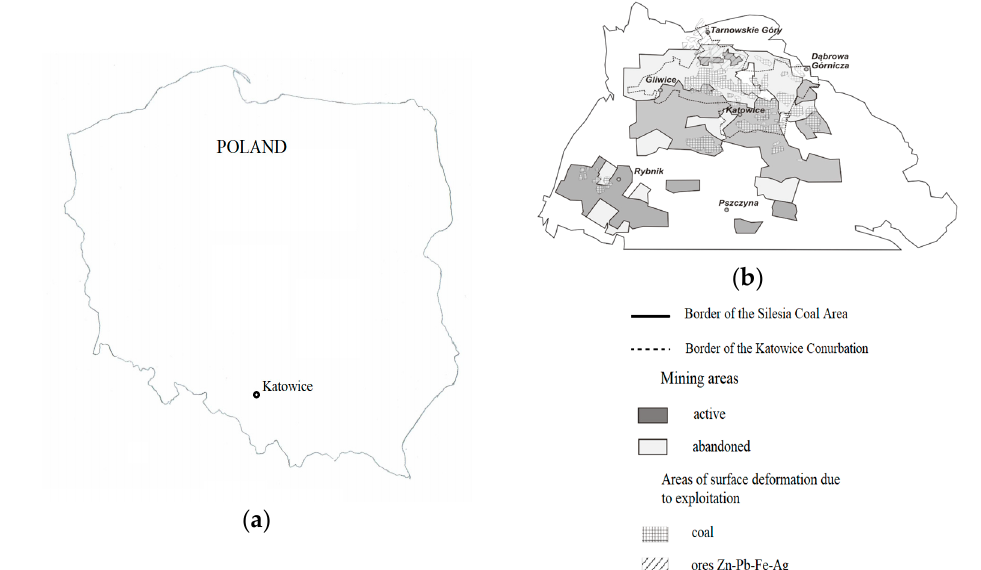
Figure 1. ( a ) Place of realization of the monitored investments. ( b ) Areas of mining activity and mining deformation in Upper Silesia.